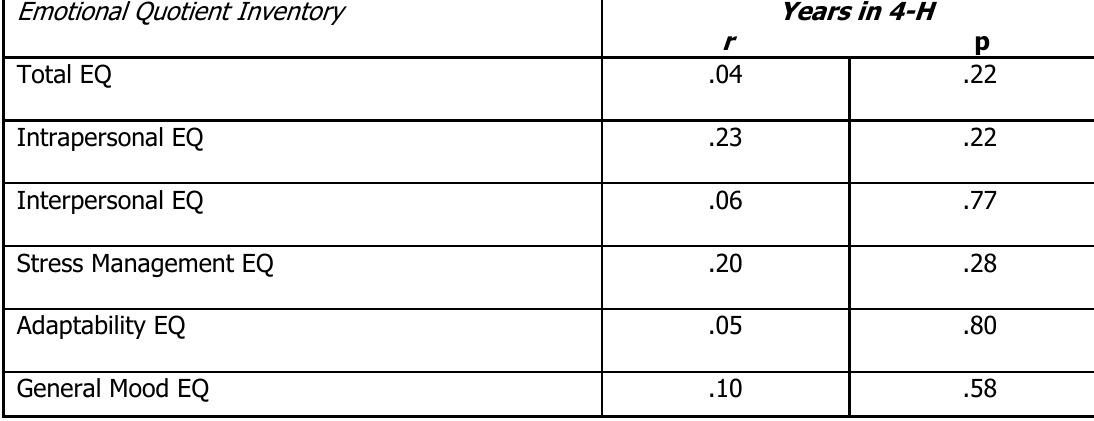
Pearson Product Moment Correlation Coefficients Between Years in 4-H and Emotional Intelligence in 2005-2006 Texas 4-H Council Members